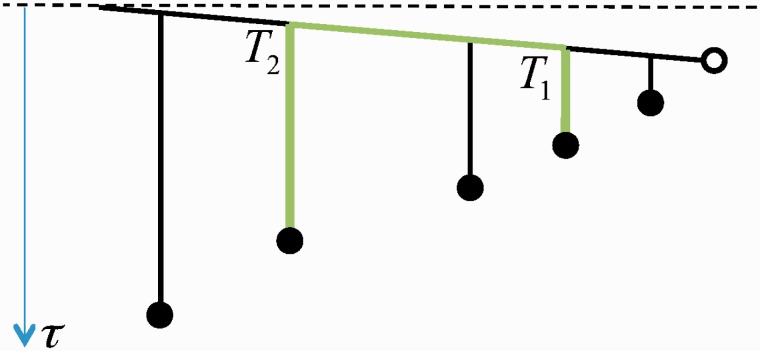
An example of the rooted tree of a pseudogene family (filled circles) stemming from one gene (open circle). The gene evolves much slower than its pseudogenes and the pseudogenes do not retroduplicate. The evolutionary distance between two leaves (green path) is the sum of the evolutionary distance covered by each pseudogene since its retroduplication event and the evolutionary distance covered by the gene between the two retroduplication events. All circles represent contemporary sequence segments.